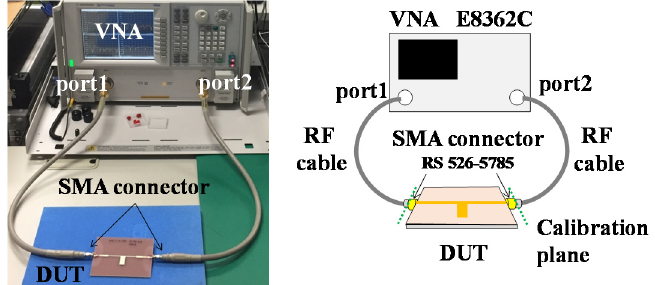
Figure 6. Measurement system by using a vector network analyzer (VNA). The device under test (DUT) is inserted between the short, open, load, and through (SOLT) calibration planes, not including SMA connectors attached to the DUT substrate.